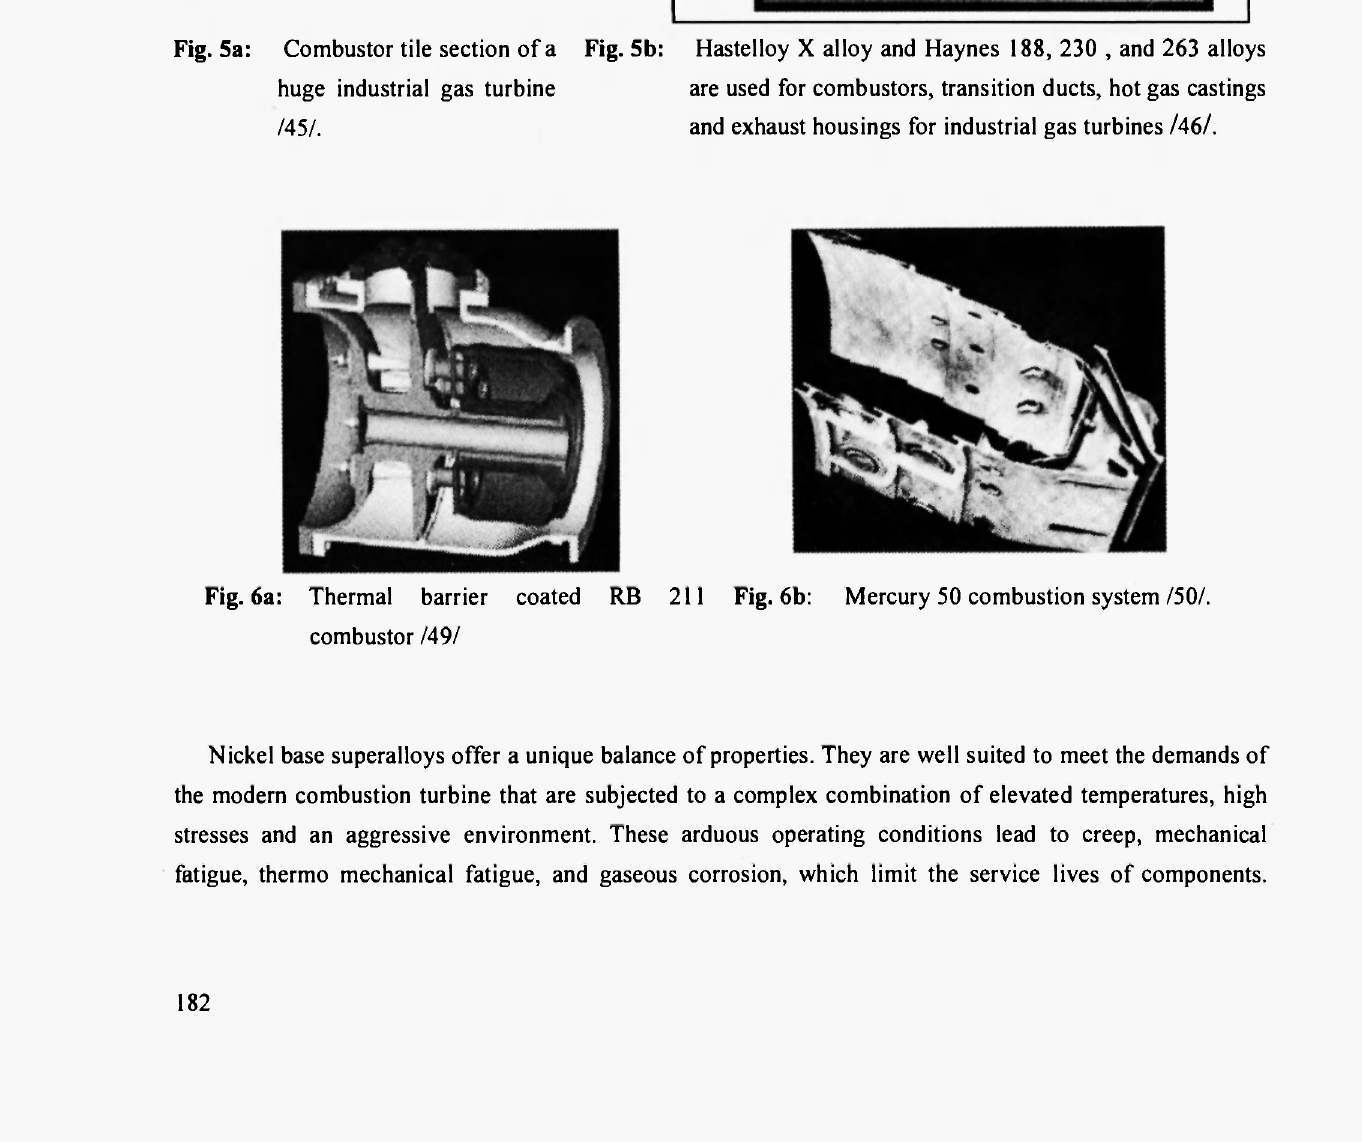
Fig. 5a: Combustor tile section of a Fig. 5b: Hastelloy X alloy and Haynes 188, 230 , and 263 alloys huge industrial gas turbine are used for combustors, transition ducts, hot gas castings /45/. and exhaust housings for industrial gas turbines /46/.